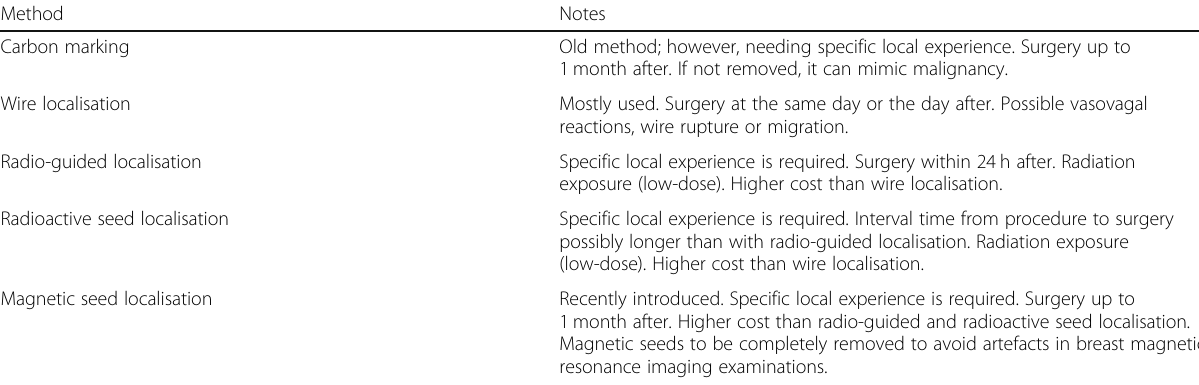
Table 2 Current options for image-guided localisation of nonpalpable breast lesions